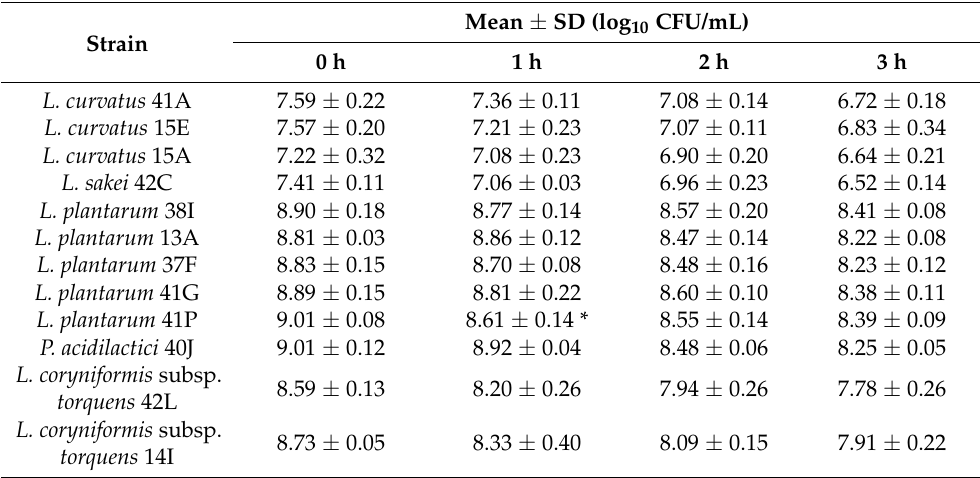
Table 6. Survival of selected LAB isolates in MRS broth supplemented with 0.3% bile salts at 37 ◦ C. Results presented as mean ± SD from three independent